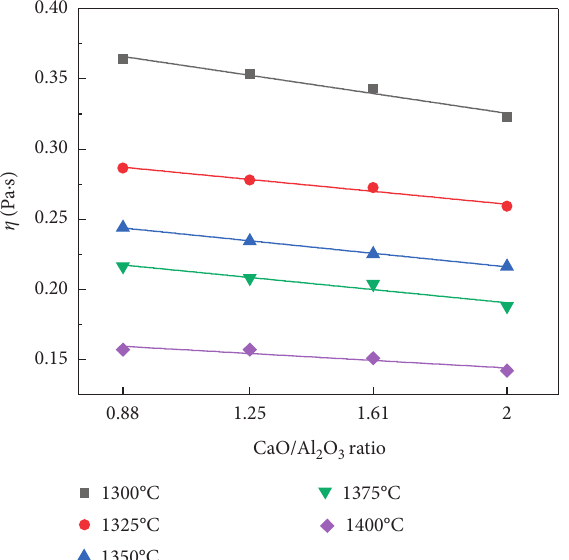
Figure 7: Viscosity of mold fluxes versus CaO/Al different temperatures.